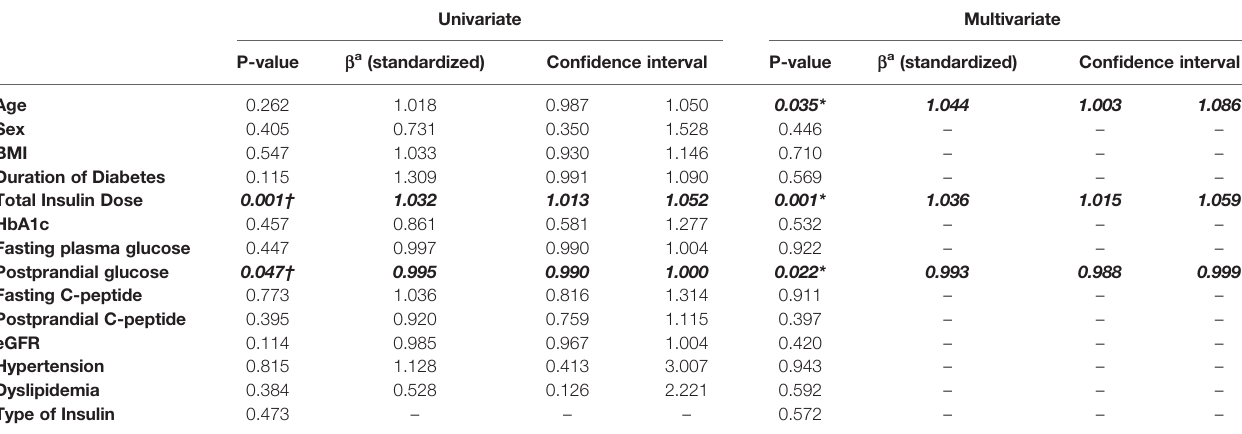
TABLE 2 | Logistic regression analysis of resumption to insulin after change from insulin to dulaglutide.